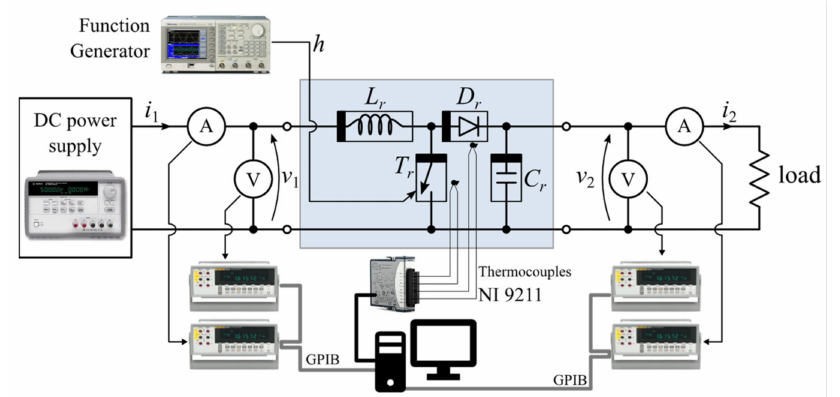
Figure 12. Experimental setup for the model